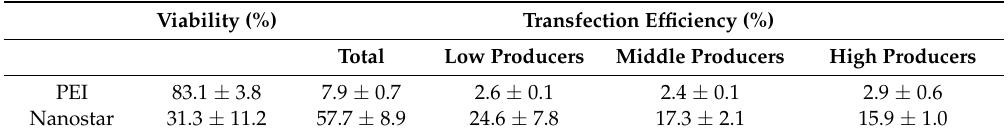
Table 2. Transfection of Jurkat cells from exponentially growing cultures using nanostars in comparison to l-PEI (PEI: